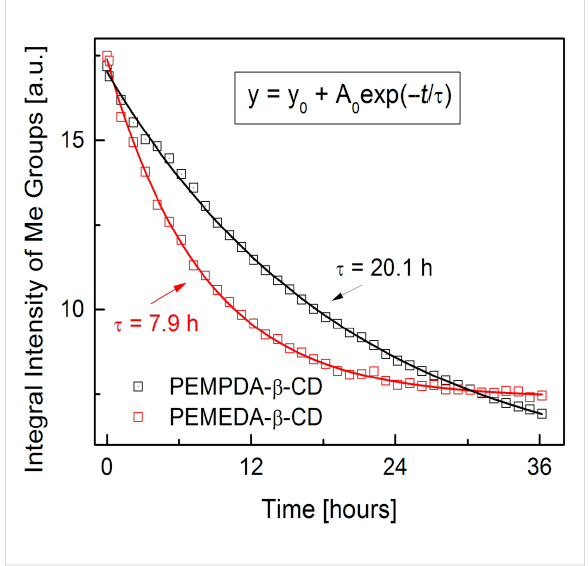
Figure 1: Decomposition kinetics of PEMEDA- and PEMPDA- β -CD at 50 °C as determined by 1 H NMR thermal